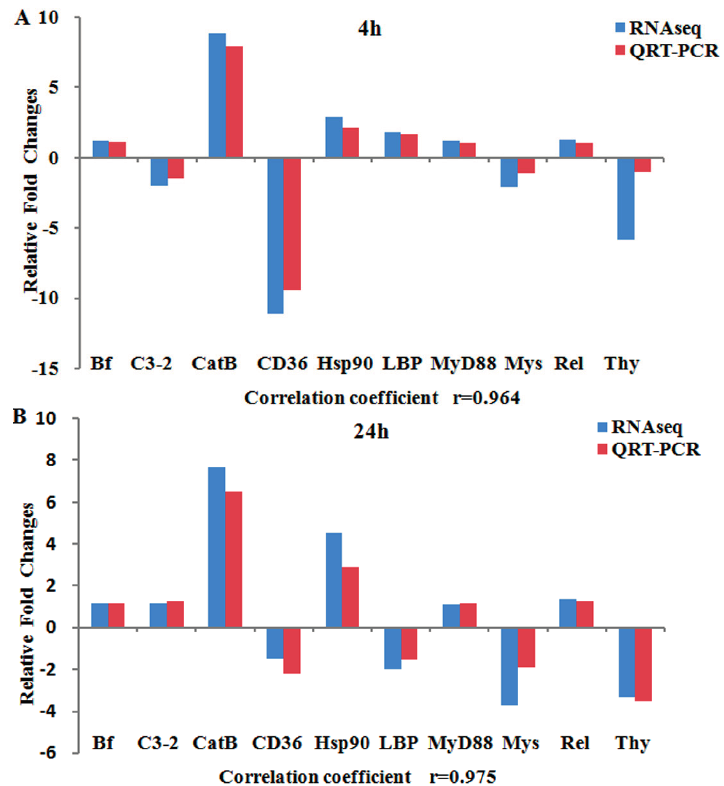
Figure 2. Validation of RNA-Seq results using qRT-PCR. The relative fold changes of 10 genes expressed in A. japonicus coelemocytes at 4 h ( A ); 24 h ( B ) and 72 h ( C ) after LPS challenge. Gene abbreviations are: Bf, complement factor B; C3-2, complement component 3-2; Cat B, cathepsin B; CD36, Cluster of differentiation 36; Hsp90, heat shock protein 90; LBP, lipopolysaccharide binding protein; MyD88, myeloid differentiation primary response gene 88; Mys, Myosin; Rel, NF- κ B transcription factor Rel; Thy, Thymosin β